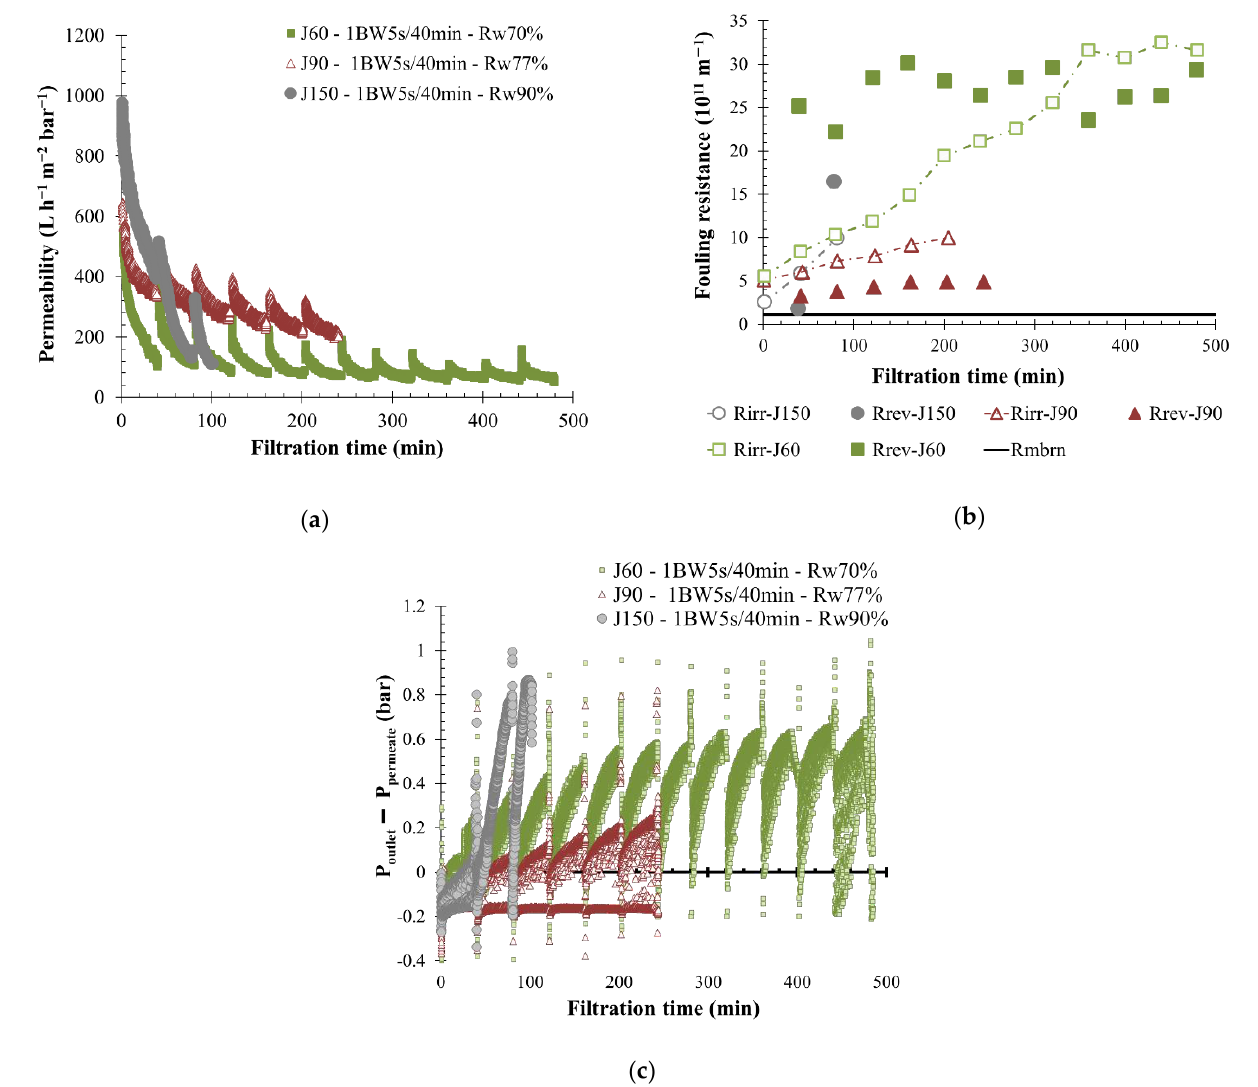
Figure 5. Influence of permeate flux on membrane filtration behavior by variation of permeability at 20 ◦ C ( a ), fouling resistance ( b ), and the pressure ration, difference between membrane outlet, and permeate side pressure ( c ) throughout the time with backwash water injected for 5 s every 40 min. A flux of 150 L h −1 m −2 (grey round), 90 L h −1 m −2 (red triangle) and 60 L h −1 m −2 (green square) are applied to the membrane. T = 20 ◦ C, feedwater from CC-KERGUELEN; SiC membrane 0.33 m 2 . Jxx is permeate flux at the xx value in L h −1 m −2 ; 1BW yy s/zz min where yy is the duration and zz the interval of filtration between two BF; and R w is the total recovery rate applied on the unit; R irr is irreversible resistance; R rev is reversible resistance and R mbrn is the membrane